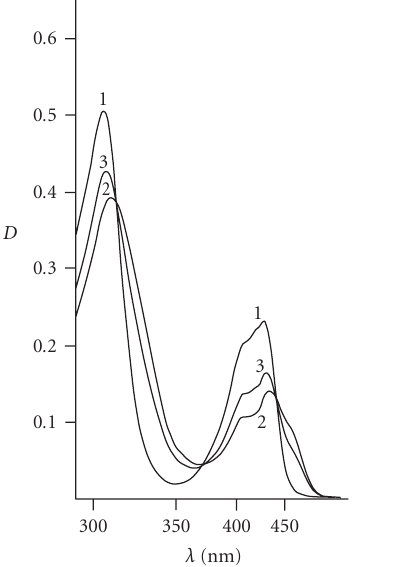
Figure 2: Absorption spectra of (1a) in toluene solution before irradiation ( 1 ); after 120 seconds ( 2 ) of irradiation ( λ irr = 365 nm) and after 120 seconds ( 3 ) of irradiation ( λ irr = 436nm); C = 2 . 5 · 10 − 5 M.